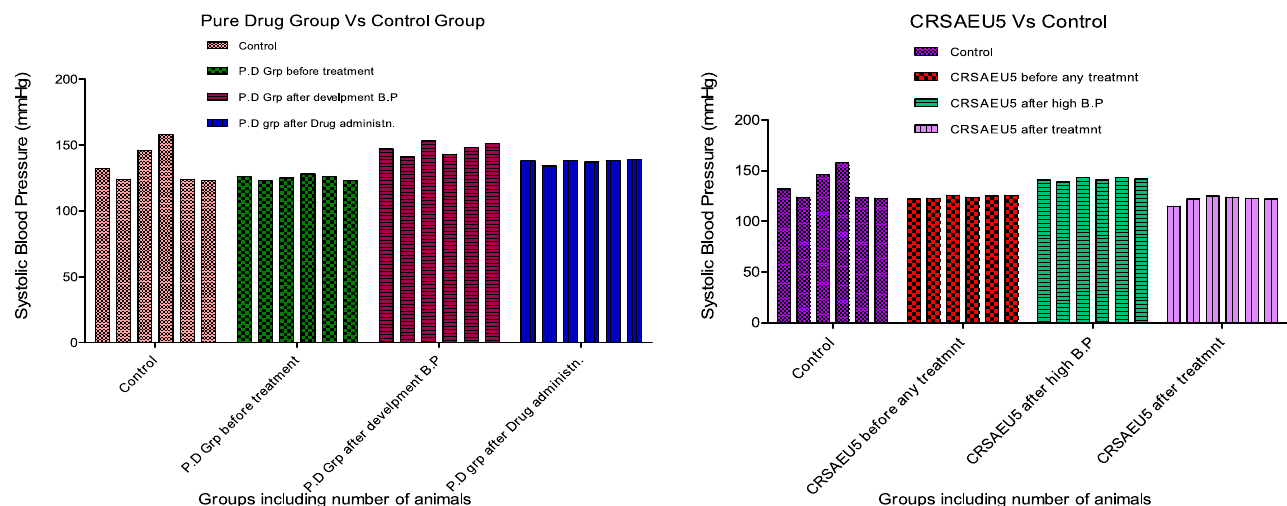
FIGURE 10 - Graphical representation of statistical ANOVA analysis of in vivo studies of optimized formulations of carvedilol, pure drug compared with